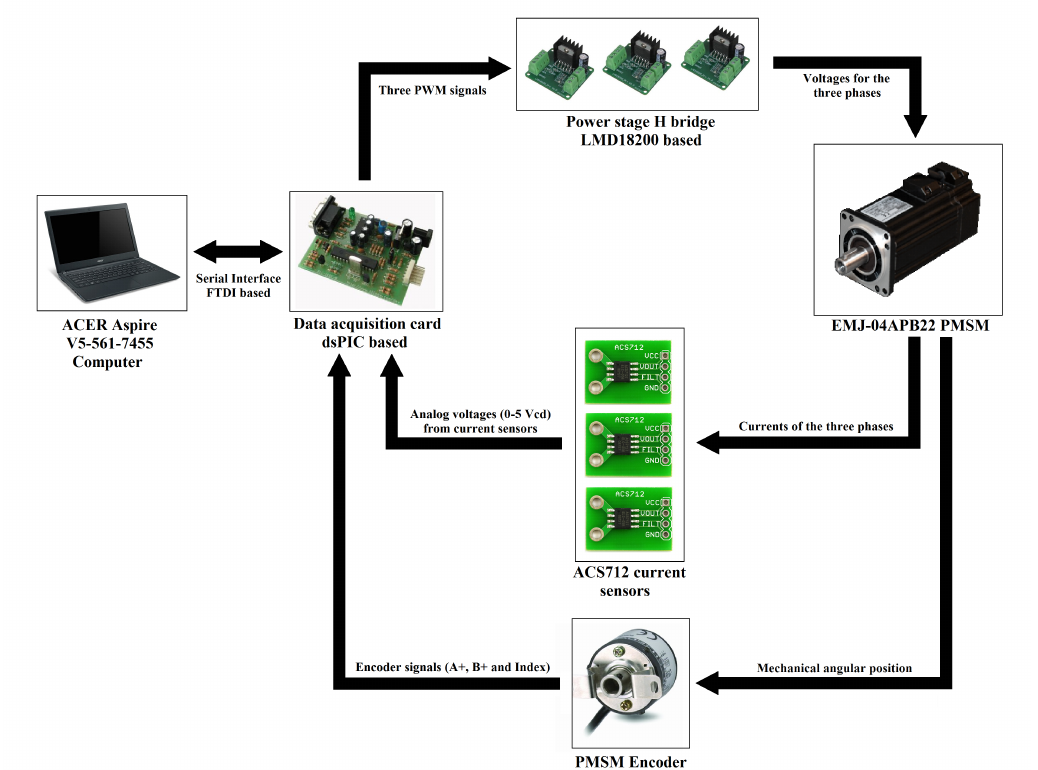
Figure 2. Interconnections diagram of the control